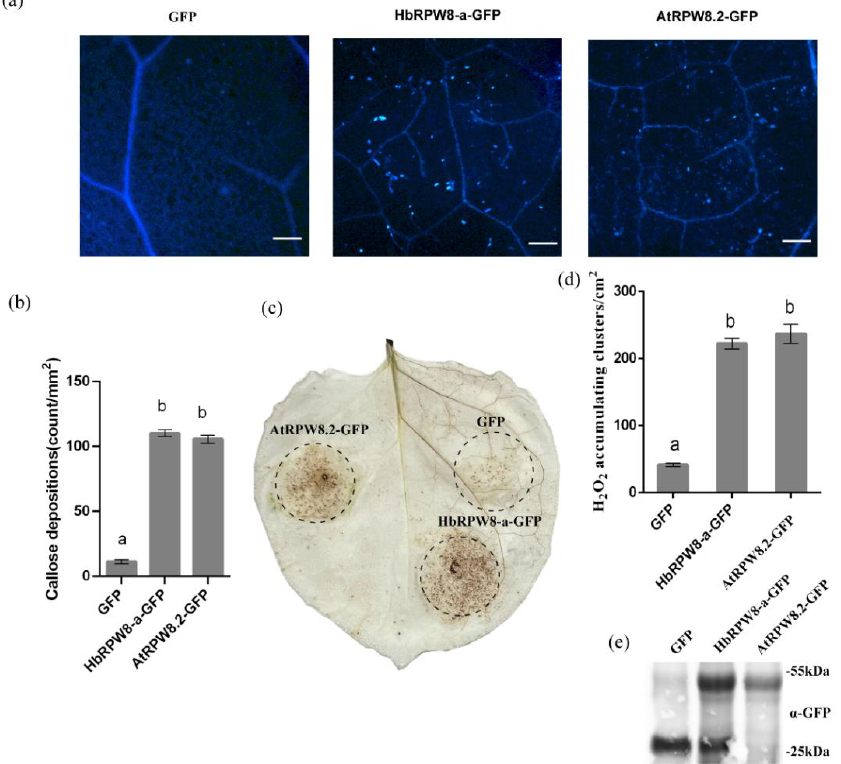
Figure 4. Plant immune responses induced by transient expression of HbRPW8-a in N. benthamiana leaves. A total of five plants were used for each treatment. Each test contained three biological replicates. ( a ) Callose deposition induced by HbRPW8-a and AtRPW8.2 genes in N. benthamiana leaves; scale bar = 100 µ m. ( b ) Average numbers of callose deposits per 1 mm 2 ; ( c ) ROS accumulation induced by HbRPW8-a and AtRPW8.2 genes in N. benthamiana leaves; ( d ) representation of DAB- positive stained clusters in tobacco leaves. Number of stained clusters was calculated per cm 2 and repeated three times; ( e ) confirmed expression of fusion protein in N. benthamiana leaves. Error bars represent the standard deviation of three independent experiments. Columns with different letters represent significant difference according to Duncan’s multiple range test at p <